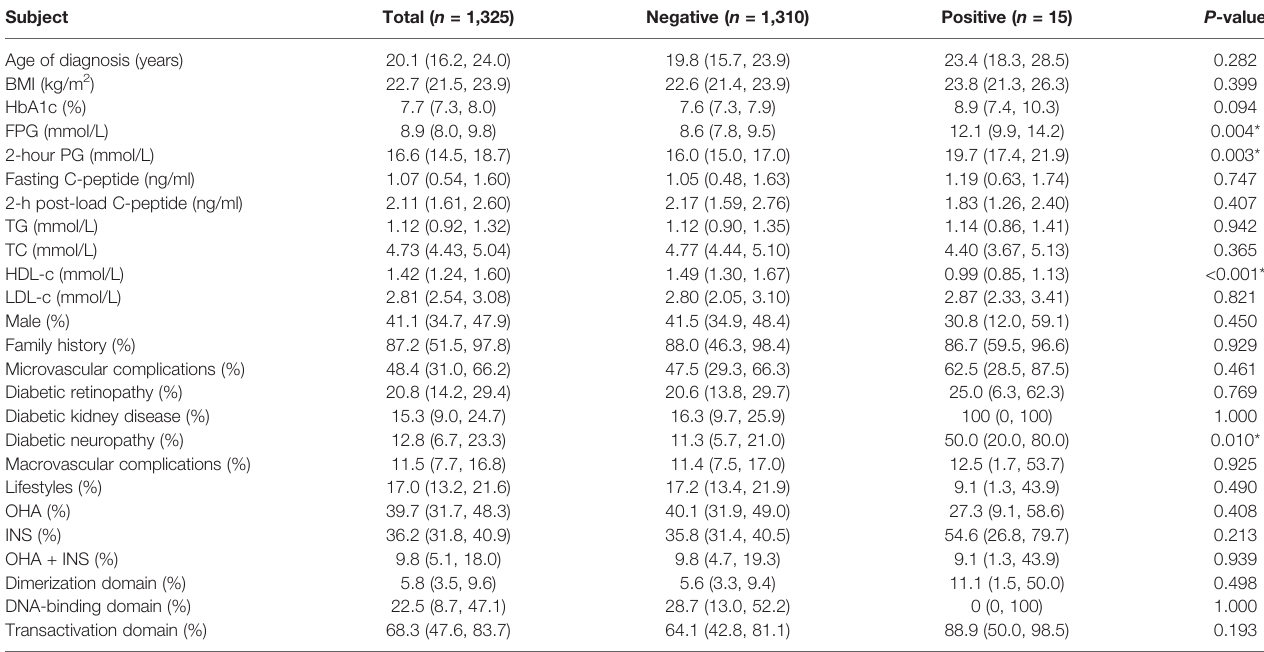
TABLE 4 | Characteristics of patients with HNF1-alpha by islet autoantibody